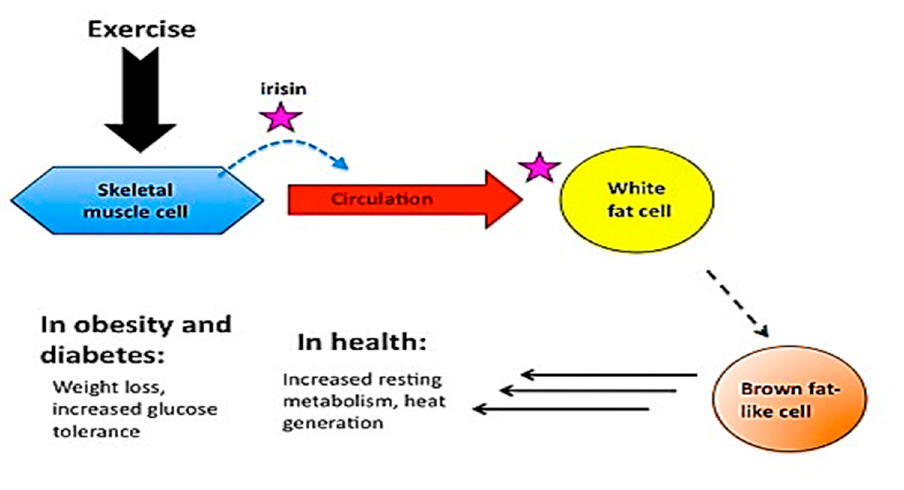
Figure 1. Effect mechanism Irisin Hormone.